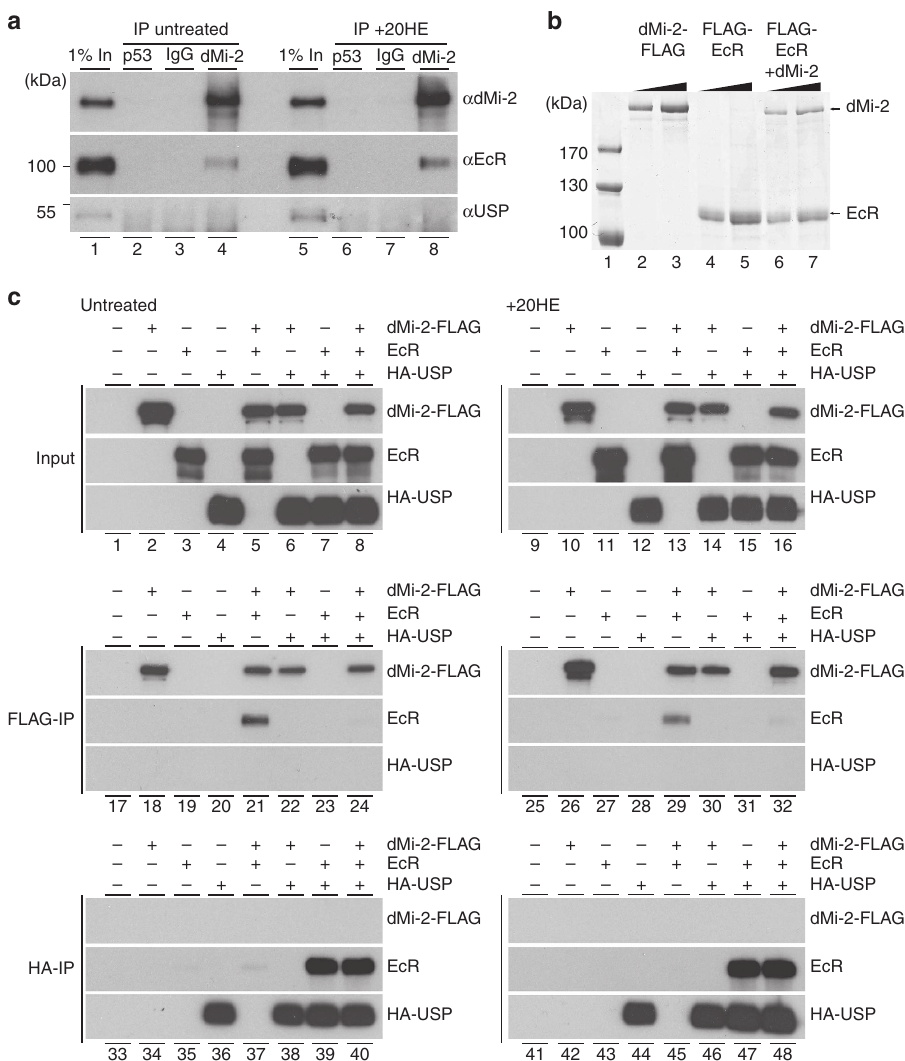
Figure 4 | dMi-2 forms a complex with EcR and competes with USP for binding to EcR. ( a ) dMi-2 and EcR interact. Nuclear extracts from untreated and ecdysone exposed ( þ 20HE) S2 cells were immunoprecipitated with dMi-2 antibody, dp53 antibody or IgG as indicated on top (lanes 2–4 and 6–8). 1% input was loaded in lanes 1 and 5. Antibodies used for western blot analysis are indicated on the right, molecular masses on the left. ( b ) Sf9 cells were infected with recombinant baculoviruses directing the expression of dMi-2-FLAG, dMi-2 or EcR-FLAG as indicated on top. Extracts were immunoprecipitated with FLAG antibody and washed with high salt buffer. Immunoprecipitates were then analysed by SDS–PAGE and Coomassie staining. Lane 1: molecular weight marker. Lanes 2, 4 and 6: 500ng protein, lanes 3, 5 and 7: 1 m g protein. ( c ) dMi-2 and USP bind EcR in a mutually exclusive manner. Sf9 cells that were either left untreated (left panels) or were exposed to ecdysone ( þ 20HE, right panels) were infected with recombinant baculoviruses expressing dMi-2-FLAG, EcR or HA–USP as indicated on top. Extracts were analysed by western blot for expression of recombinant proteins (top panels). Extracts were immunoprecipitated with FLAG (FLAG IP, middle panels) or HA (HA IP, bottom panels) antibody